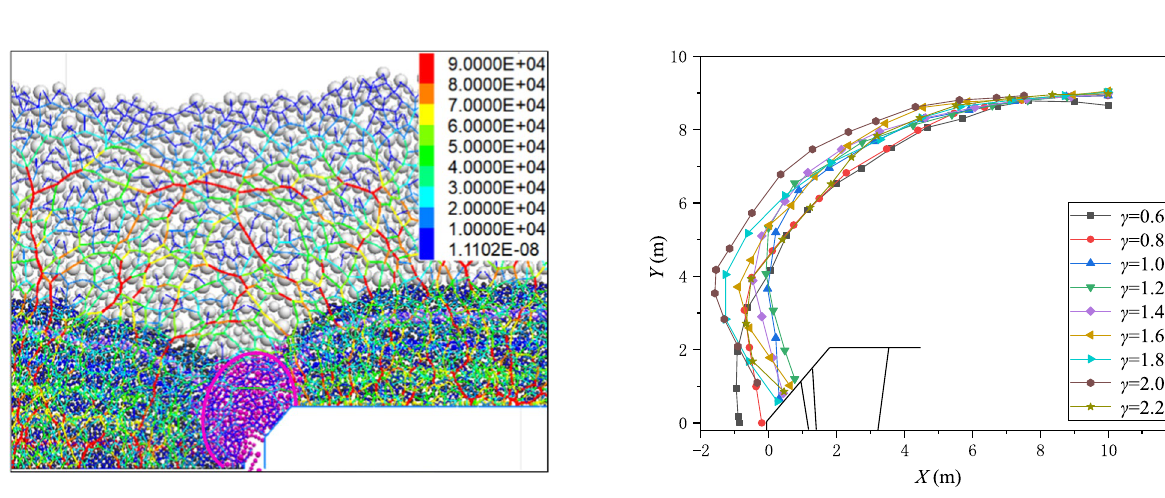
Fig. 18 Shapes of the final top-coal boundary for different